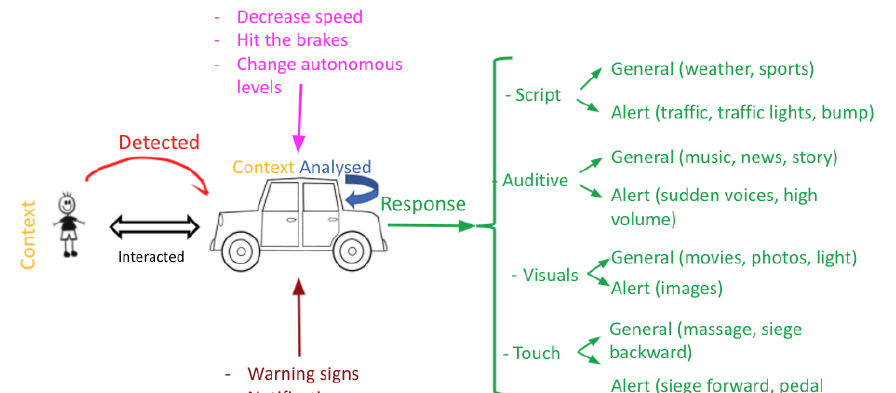
Figure 11. Example 1: Chatbot.